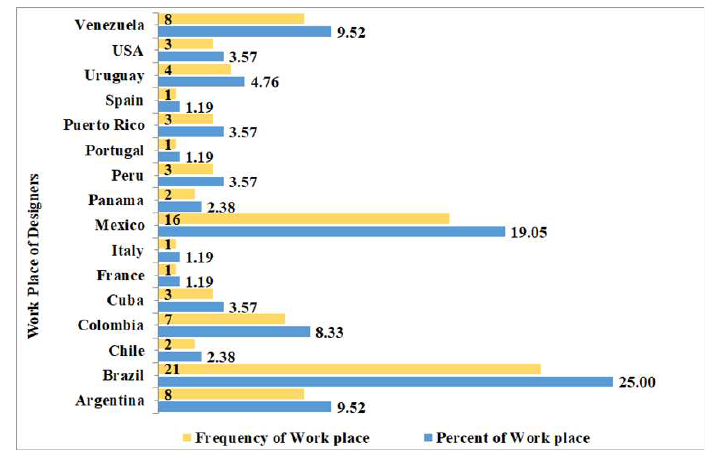
Figure 4. Workplaces of the designers.